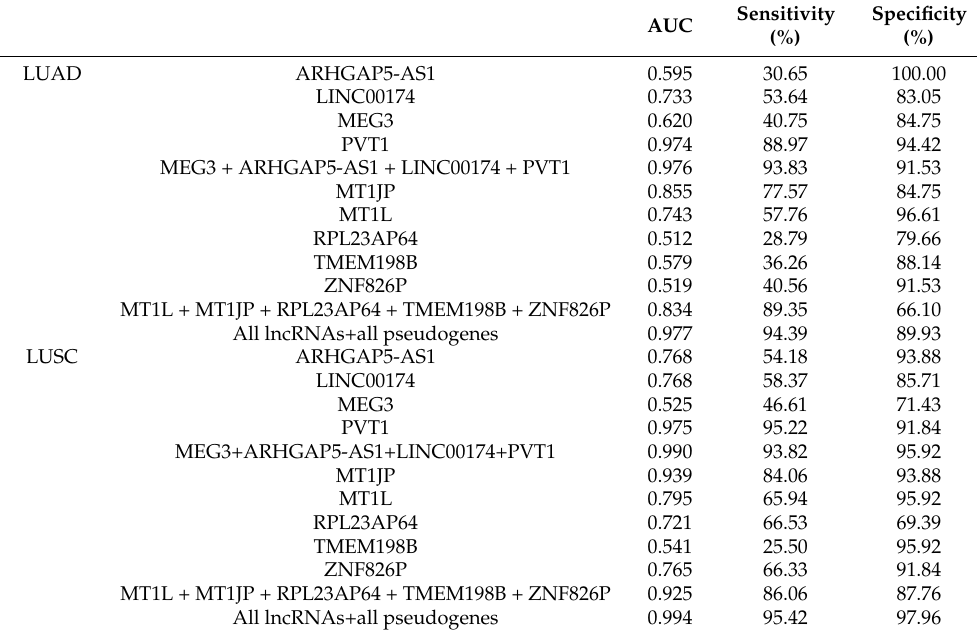
Table 4. Diagnostic values of our identified lncRNAs and